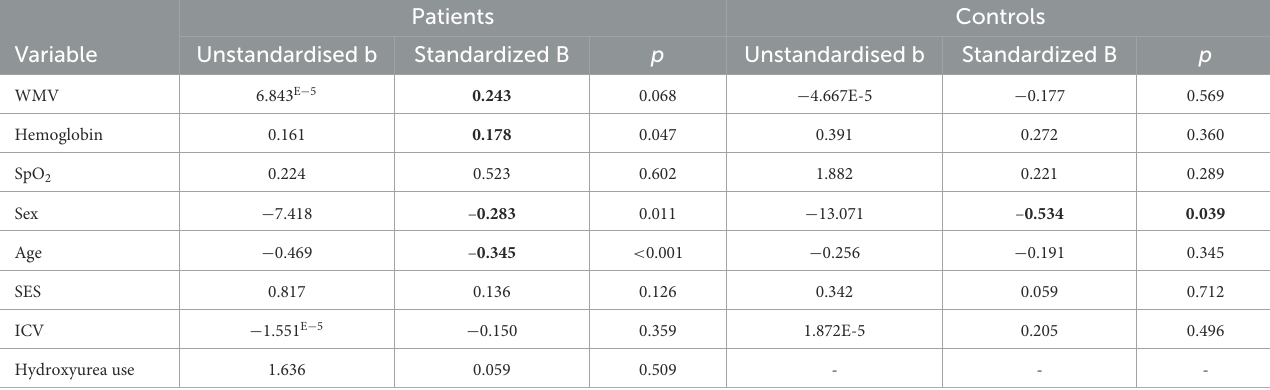
TABLE 4 Regression coefficients for processing speed index in patients.